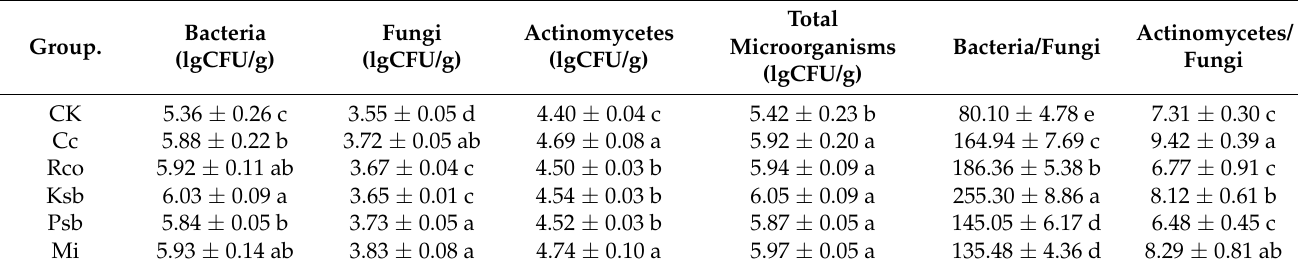
Table 2. Comparison of rhizosphere microbial number of F. taipaiensis treated with different microbial inocula.